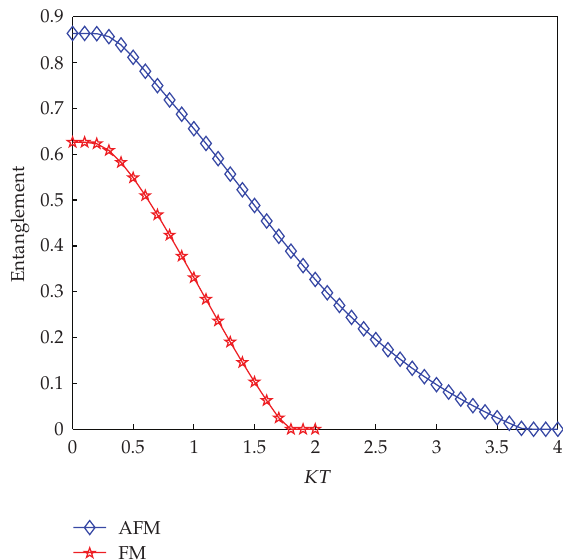
Figure 3: (cid:4) Color online (cid:5) The amount of the first maximum of entanglement between two ends in a chain of length 10 versus the temperature for both the case of FM chain and AFM